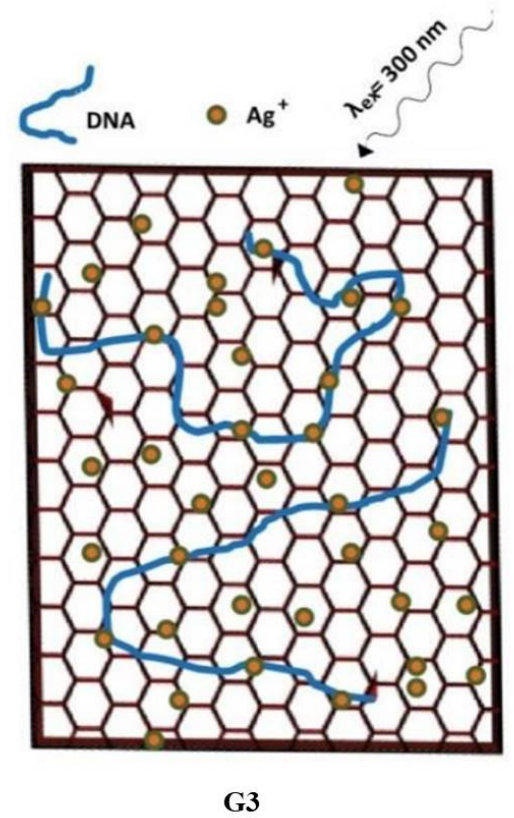
Figure 5. Graphical diagram of GQDs/NGQD modified with DNA ( G3 ) for the sensing of Ag + . Reprinted from [56] with permission from IOP Publishing Ltd.